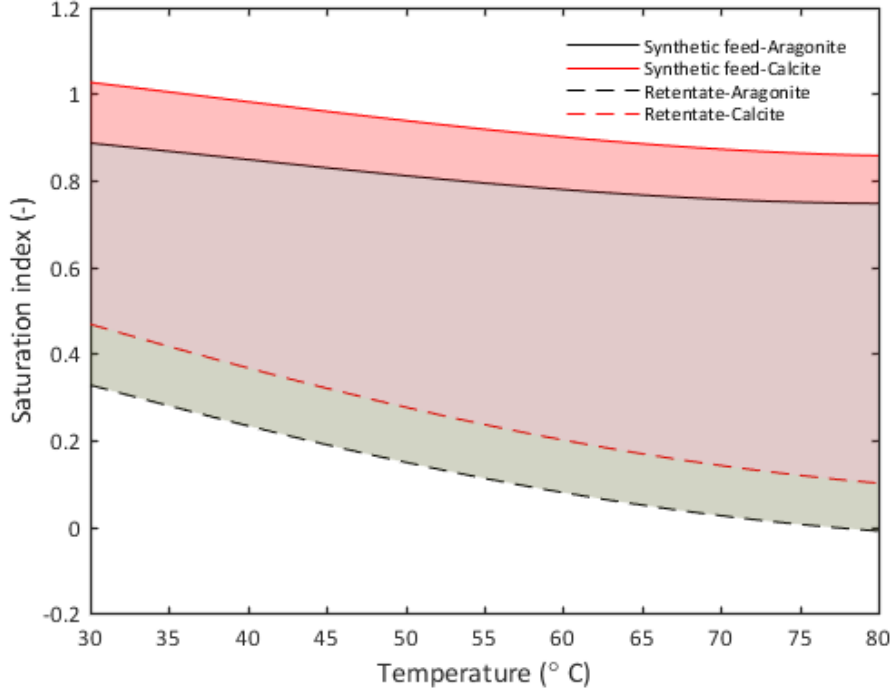
Figure 4. Aqueous speciation equilibrium of synthetic RO brine feed without antiscalant and its corresponding retentate. Solid lines indicate the saturation indices of the main mineral precipitates in synthetic RO brine feed without antiscalant, while dashed lines indicate the corresponding saturation indices for the retentate. The shaded area indicates the drop in saturation indices caused by precipitation on the membrane surface. Modeled using PHREEQC software.